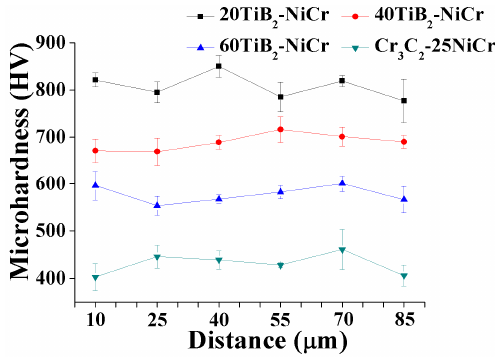
Figure 5. Microhardness of TiB 2 ‐ NiCr and Cr 3 C 2 ‐ 25NiCr coating.